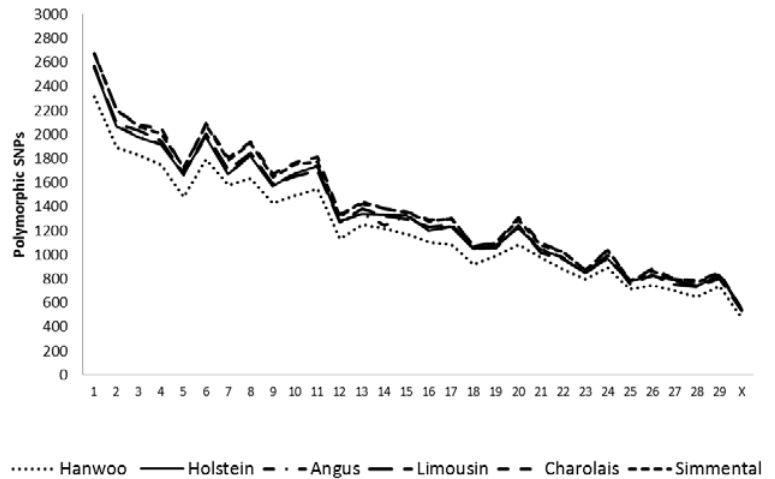
Figure 2. Polymorphic SNPs dynamics across the chromosomes of different cattle breeds, unknown chromosomes were excluded (Polymorphic, ≥ 0.05- ≤